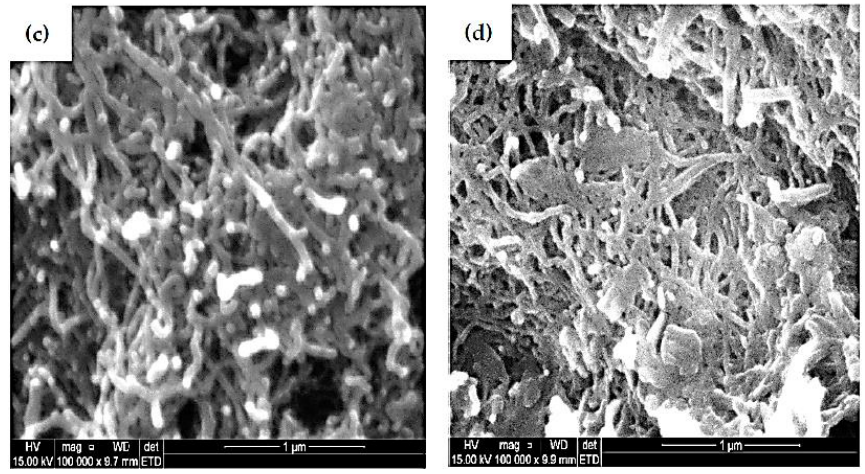
Figure 6. SEM images of ( a ) NiNp, ( b ) Pc, ( c ) fMWCNTs, and ( d ) NiPcMWCNTs nanocomposite.